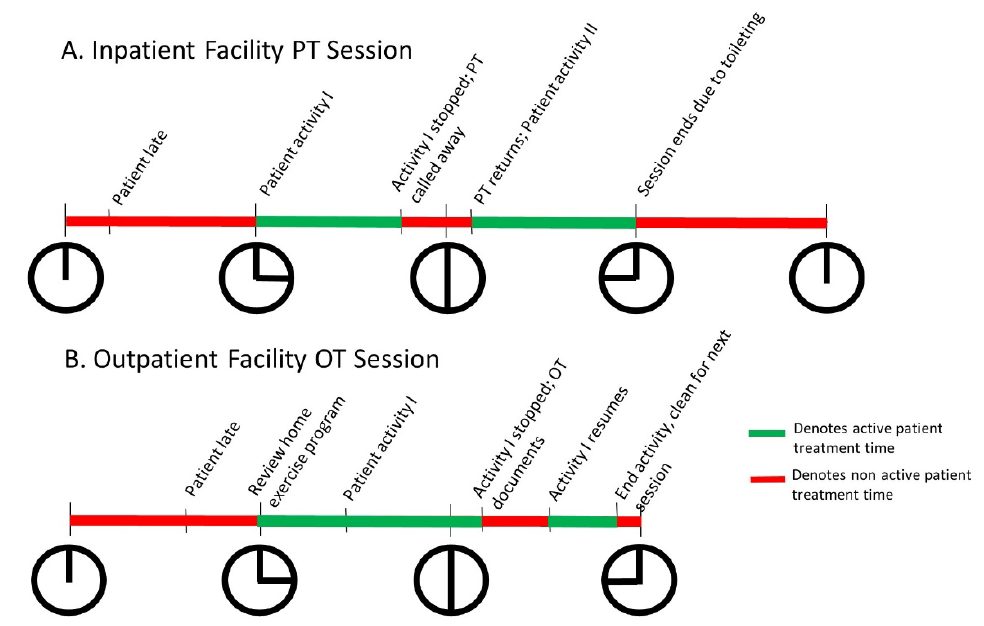
Figure 1. Clinicians encounter many barriers to spending time in direct patient care. Examples of inpatient physical therapy (PT) 1 h session ( A ) and outpatient occupational therapy (OT) 45 min session ( B ).